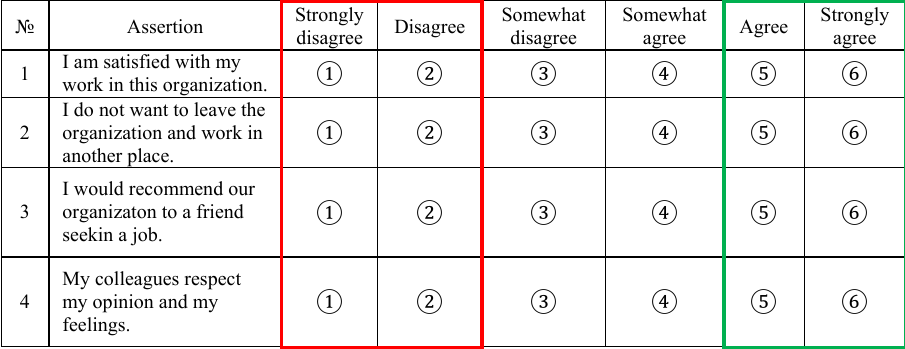
Fig. 3. Survey results evaluation.